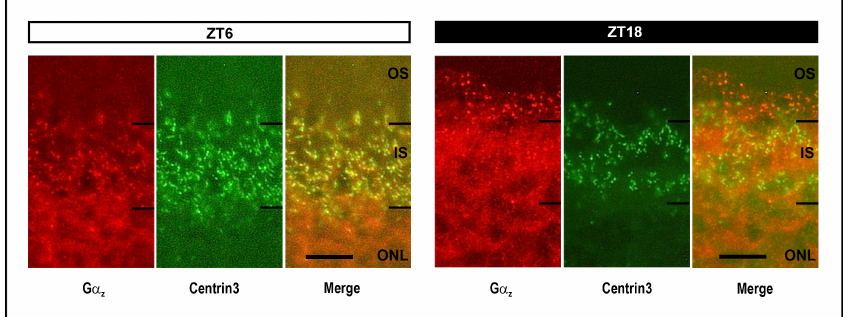
Fig 3. Daily translocation of G α z immunoreactivity. Micrographsof coronal sections of the retina, labelled for G α z (red) and centrin3(green), a marker of the connectingcilium and the photoreceptorinner segment (IS). The representative immunofluorescent image shows that G α z protein is abundant in photoreceptors where its subcellular localizationis under daily regulation.G α z immunoreactivity mainly occurs in the inner segment (IS) at ZT6 and in the outer segment (OS) at ZT18. The solid bars indicatethe dark period. ONL, outer nuclearlayer. Scale bar, 10 μ m.